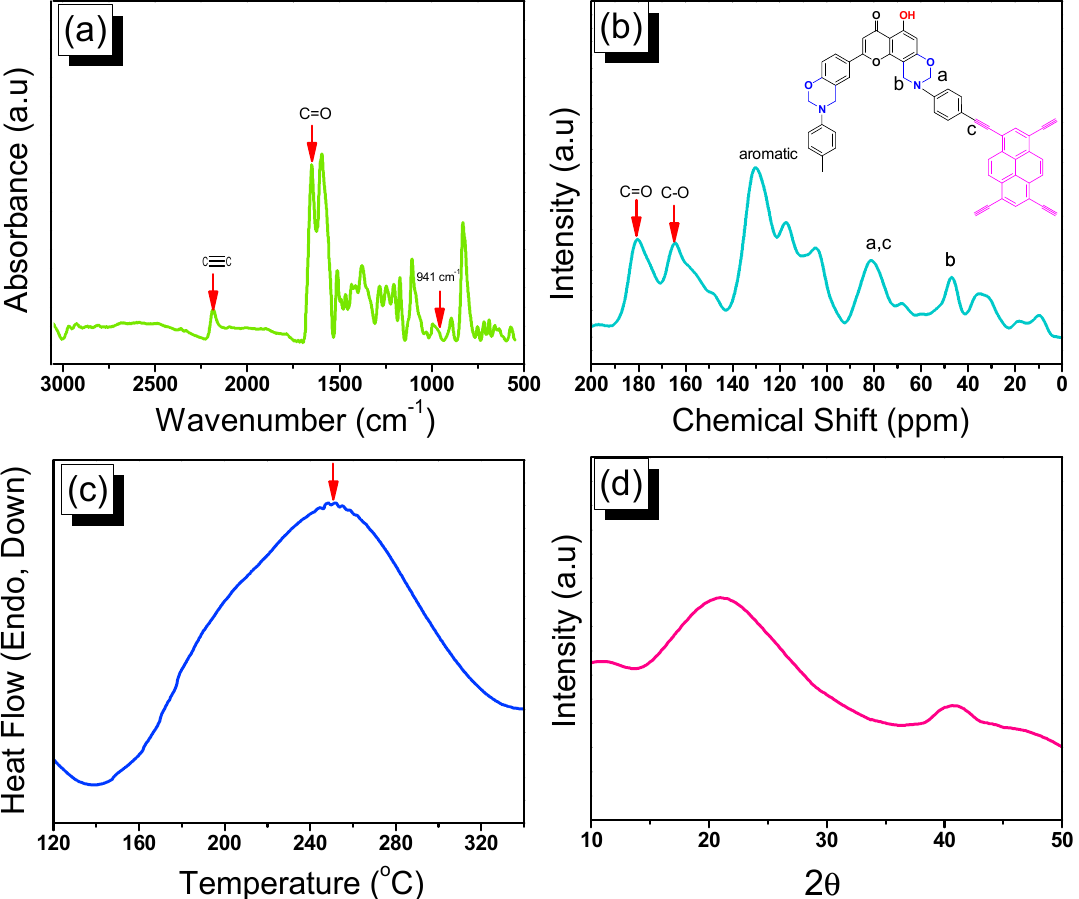
Figure 4. ( a ) FTIR spectrum, ( b ) solid state 13 C CP/MAS NMR spectrum, ( c ) DSC trace, and ( d ) XRD profile of PA-BZ POP, recorded at room temperature.